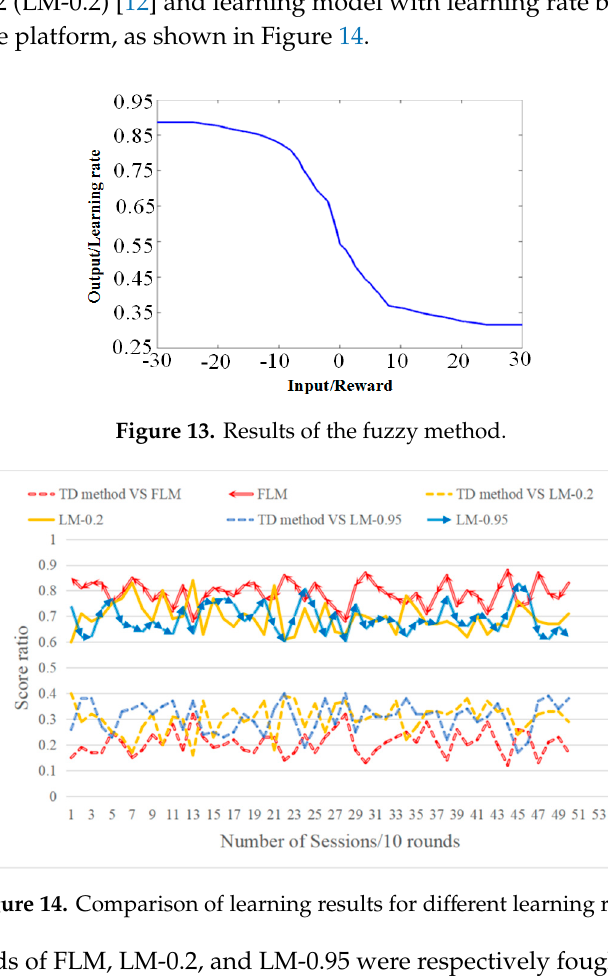
18 of 22 Figure 11. The curve of the fluctuation value of the total score ratio. ( a ) ( b ) Figure 12. The curve of the Defensive score. ( a ) The defensive score of neural network (NN) without adaptive momentum (AWM); ( b ) The defensive score of NN with AWM.